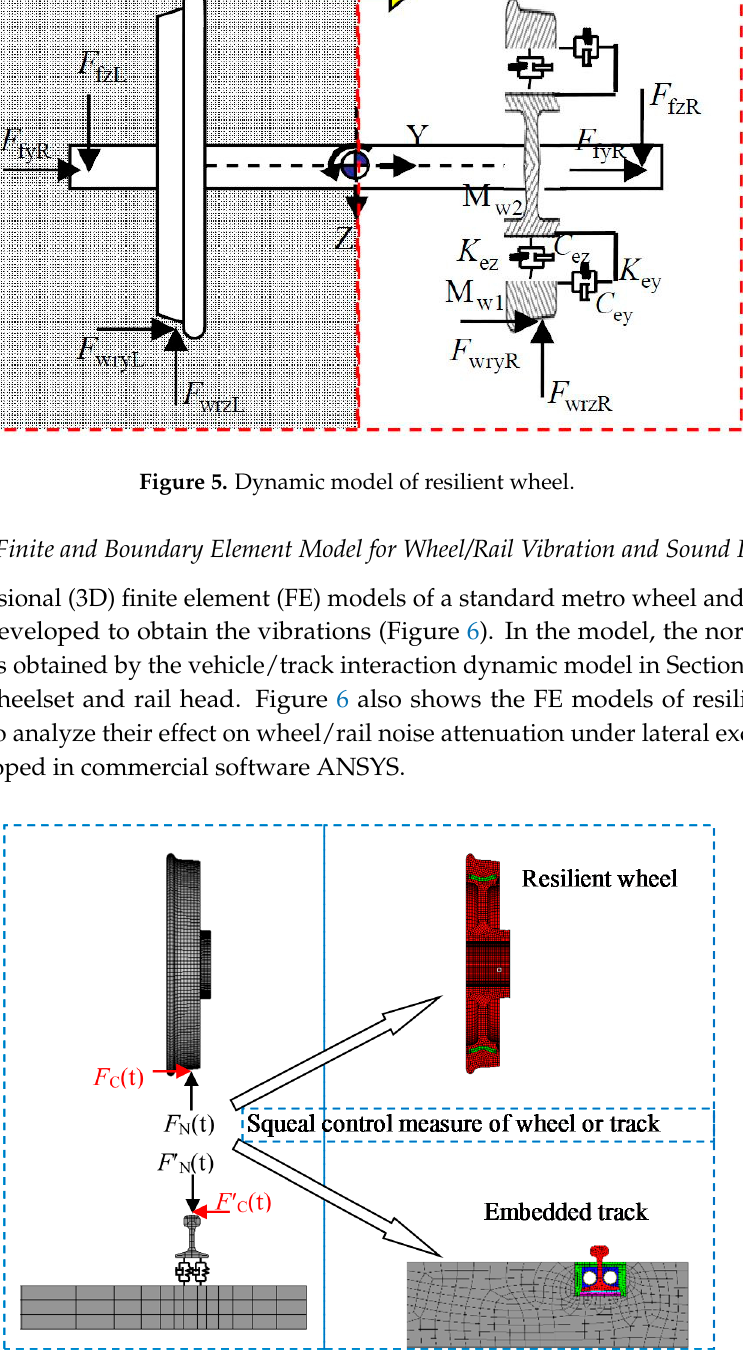
Figure 6. Dynamic model of resilient wheel and embedded rail.